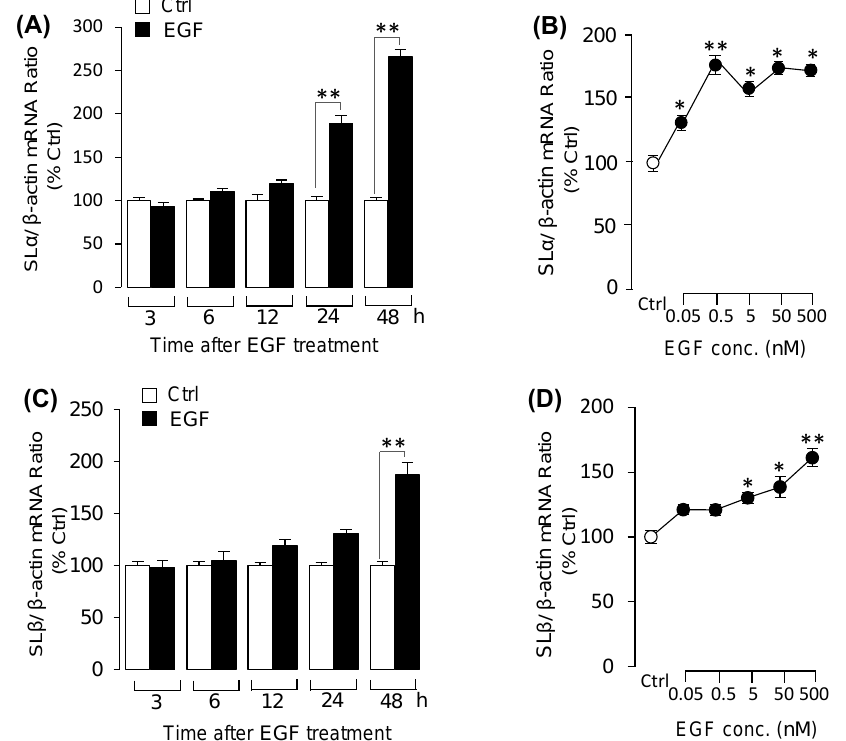
Figure 4. EGF induced somatolactin alpha (SL α ) and somatolactin beta (SL β ) mRNA expression in pituitary cells. ( A ) Time experiment of EGF (50 nM) on SL α mRNA expression from 3 to 48 h. ( B ) Dose experiment with increasing dose of EGF (0.05–500 nM) on SL α mRNA expression for 48-h incubation. ( C ) Time experiment of EGF (50 nM) on SL β mRNA expression. ( D ) Dose experiment with increasing levels of EGF (0.05–500 nM) on SL β mRNA expression for 48-h incubation. After drug treatment, the total RNA was collected and prepared for SL α and SL β mRNA expression by using real-time PCR. Data presented are expressed as mean ± SEM ( n = 4). p < 0.05 (“*”) and p < 0.01 (“**”) were used to present significant di ff erences among each group, (ANOVA followed by a Dunnett test).